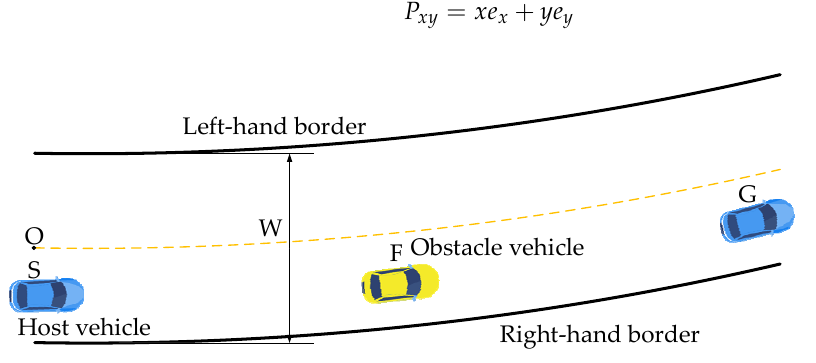
Figure 1. Curved road environment.